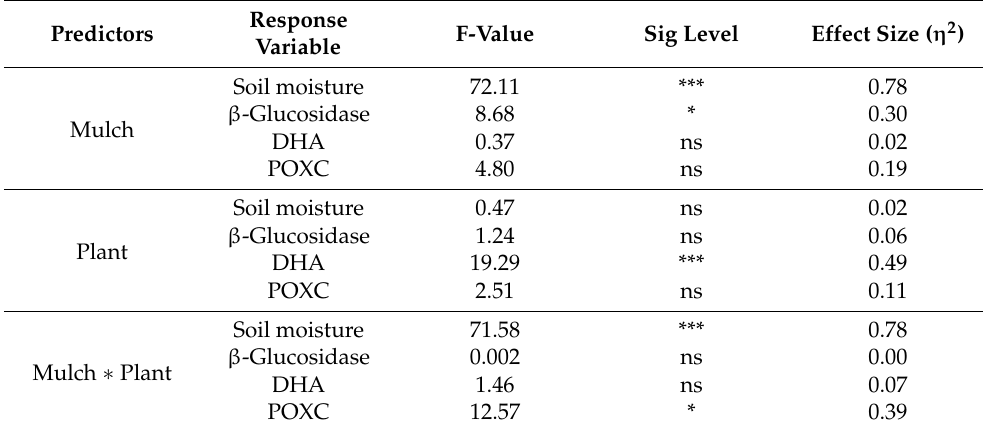
Table 2. The effect of the wool mulch and plant interactions at the Greek site. Results showing the tests of between-subject effects